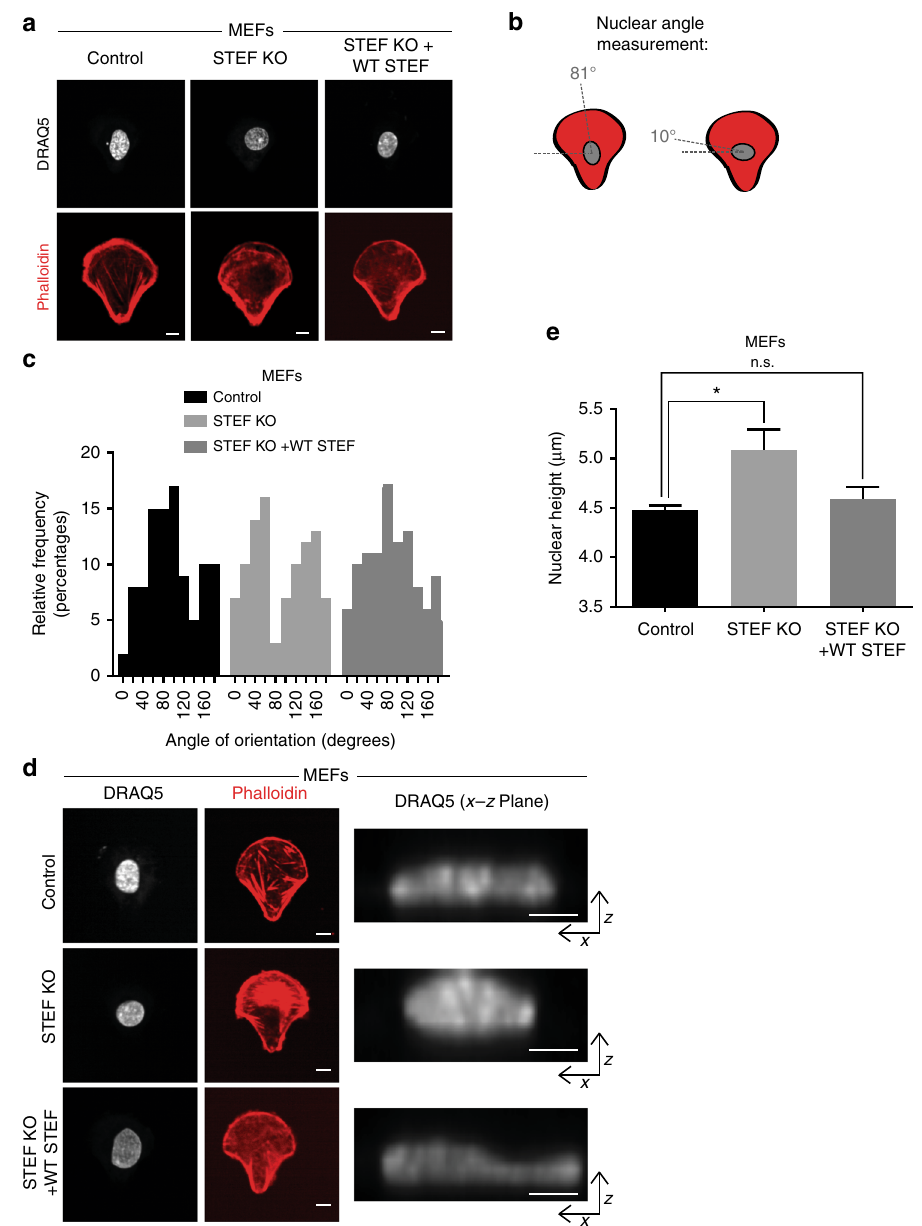
Fig. 5 STEF regulates nuclear re-orientation and height. a Spinning disc confocal images of either control MEFs (Control), or MEFs depleted for endogenous STEF (STEF KO) or depleted for endogenous STEF, but re-expressing exogenous wild-type STEF (STEF KO + WT STEF) plated on collagen-coated cross- bow micropatterns, fi xed after 7 h and stained for nuclei (DRAQ5) and actin (Phalloidin). b Schematic of the front-rear polarised morphology and nuclear position on micropatterns also showing how nuclear angles were measured. c Histogram showing quanti fi cation of nuclear angles relative to x axis in MEFs of a . Representative replicate from two independent experiments. Analysis conducted using the ' fi t ellipse' tool on ImageJ. d Representative immuno fl uorescence images of MEFs plated as in a . Right panels, maximal projection images of the x – z plane of the nucleus. e Quanti fi cation of nuclear height of MEFs of d . Image z -stacks for DRAQ5 stain were imported into the Imaris software and the shortest principal axis of the nucleus (height) was measured. Values represent the mean of three independent experiments, >100 cells per condition, per replicate. Statistical signi fi cance was veri fi ed using a one-way ANOVA, using Dunnett ’ s multiple comparison test to compare the means of each sample to the control. * p < 0.05, n.s. = not signi fi cant. Error bars represent S.E.M. Scale bars = 10 µ m